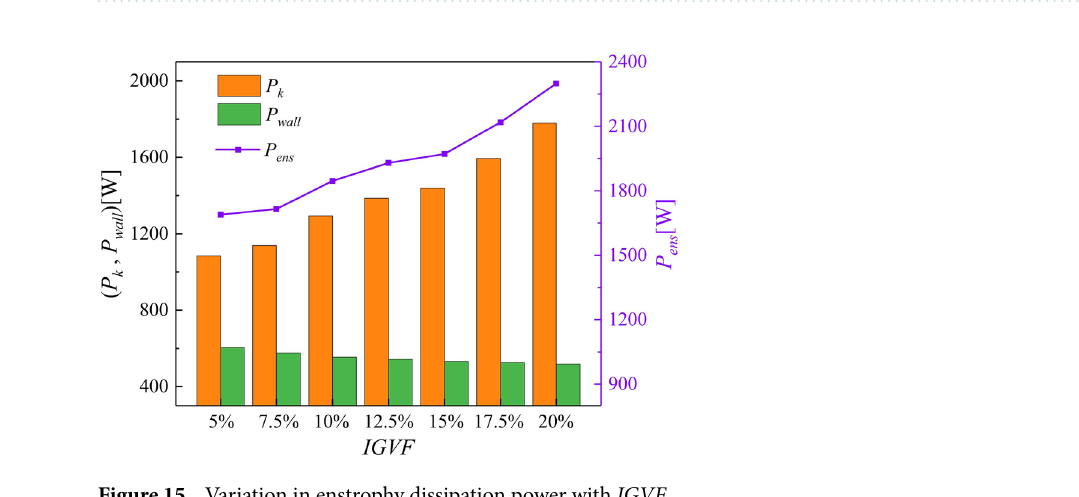
Figure 14. Three-dimensional streamline in the impeller and pressure fluctuation intensity on radial sections. ( a ) Three-dimensional streamline and ( b ) pressure fluctuation intensity.